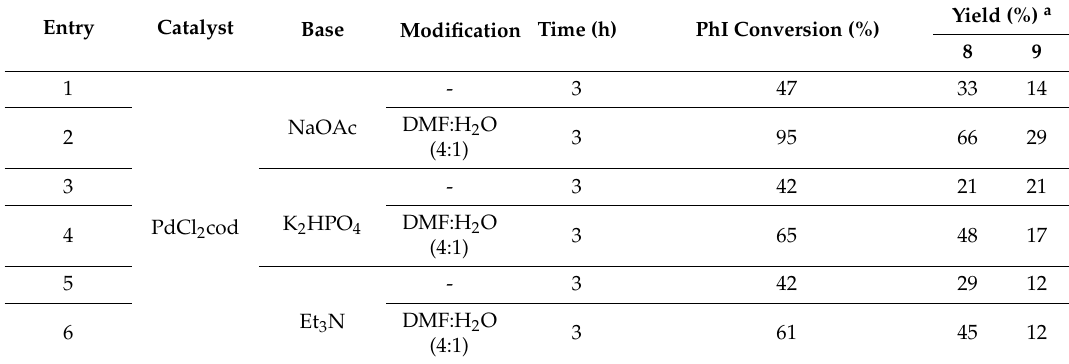
Table 7. Results of the Heck arylation of linalool with